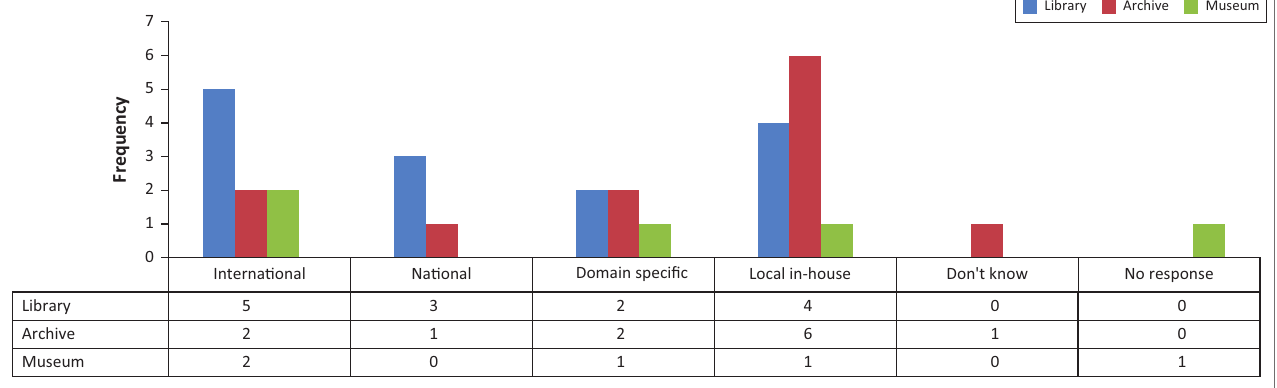
FIGURE 6: Level of standards ( N =